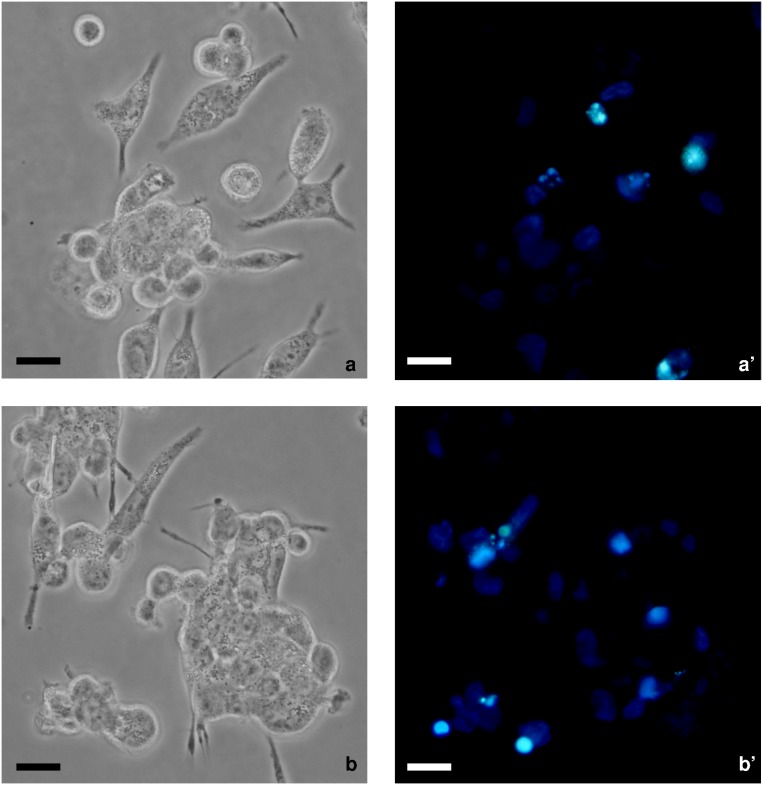
Involvement of ecto-CRT in phagocytosis of RBAc photosensitized HeLa cells.Phase contrast micrographs (a, b) and fluorescence micrographs of Hoechst (1 µg/mL) labeled (a’–b’) apoptotic RBAc-PDT-induced (RBAc 10−5 M 60 min followed by 90 seconds irradiation with green light (1.6 J/cm2) and then by recovery in fresh medium for 12 h, in the presence of 3-MA 10 mM and Nec-1 300) HeLa cells co-incubated with human macrophages. a–b) inhibition of ecto-CRT by polyclonal chicken anti-CRT. Bars = 10 µm.